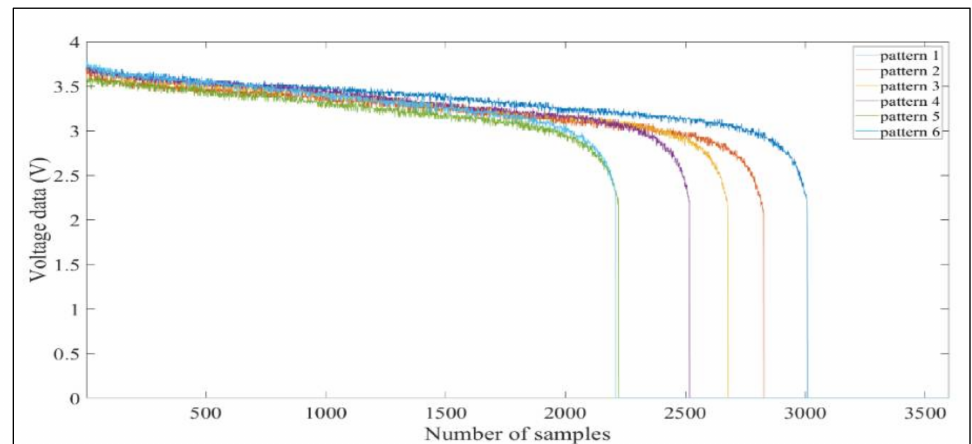
Figure 8. Battery discharge data for testing.